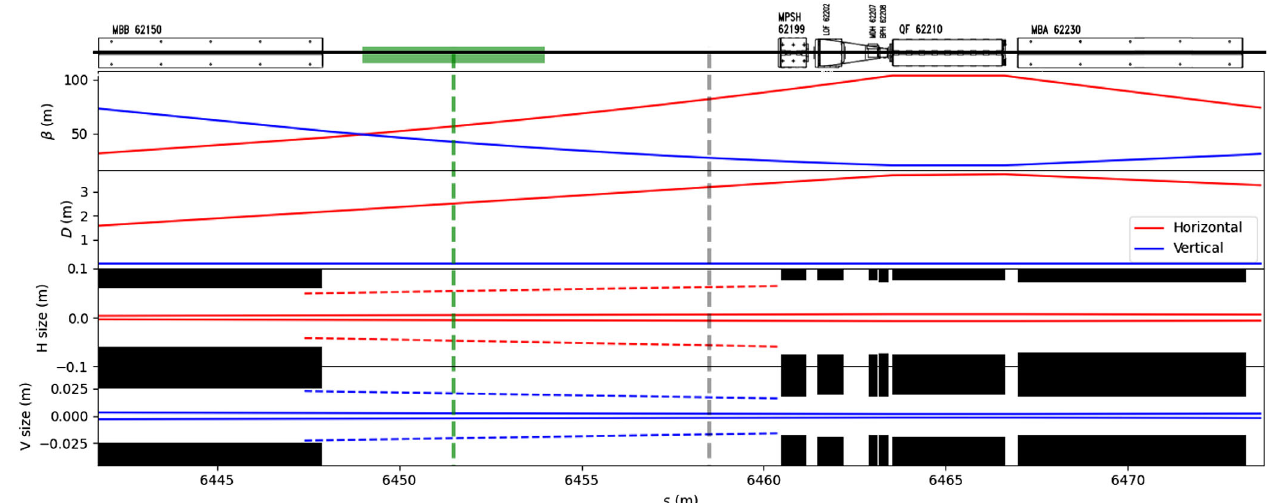
FIG. 2. Layout (top), betatron and dispersion functions (middle), and horizontal and vertical beam sizes as a function of the coordinate of the SPS ring (bottom). The beam goes from left to right. The layout clearly exhibits from left to right, a dipole magnet, in green the location of the Fabry-Perot cavity described in this paper, a corrector, an octupole, a BPM, another quadrupole, and a dipole. The betatron and dispersion functions for the horizontal and vertical directions are shown in red and blue, respectively. Note that there is no vertical dispersion while the horizontal dispersion is about 2 m at the interaction point between ions and the laser, approximately identified with the green dashed line. The vertical gray dashed line represents the location of an x-ray detector that will be installed to measure the scattered photons. The rms beam size is depicted by the plain double red (horizontal) and blue (vertical line) of the bottom plots. Black boxes represent the aperture of the magnetic elements. The dashed red and blue lines represent the stay-clear regions described in the text.